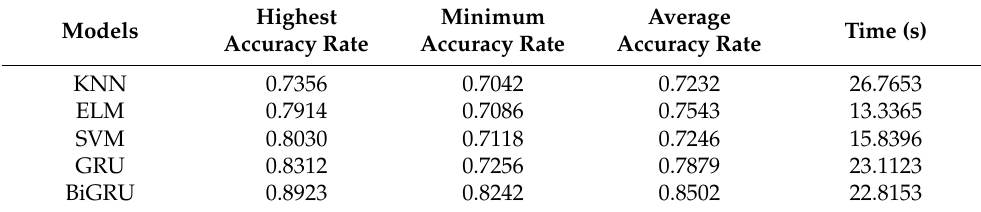
Table 10. Repeat Training Results for Different Models.